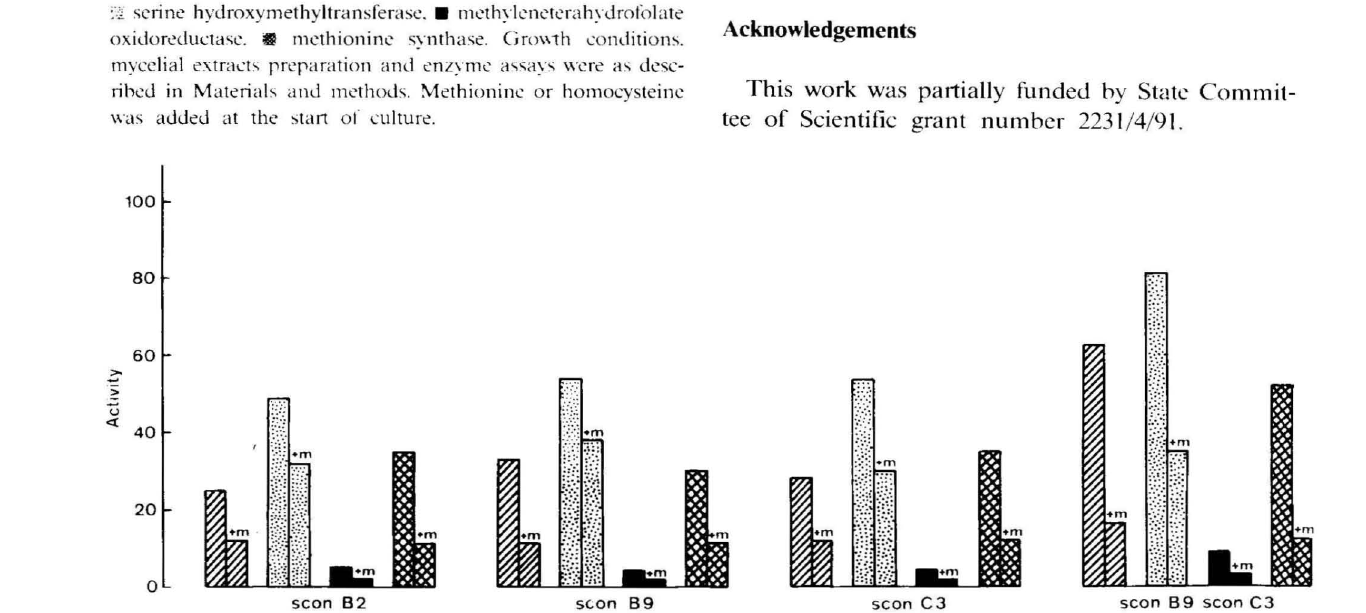
Figure 2. Activity of folate metabolizing enzymes in wild strdin cultured in absence and presence of 5 mM methionine (+ m) or 3 mM homex:ysteine ( t h). ~ dihydrofolate reductase. :··i serine hydroxymethyhransferasc . • methykncterahydrofolate oxidoreductase. ill methionine synthase. Gro\\lh conditions.